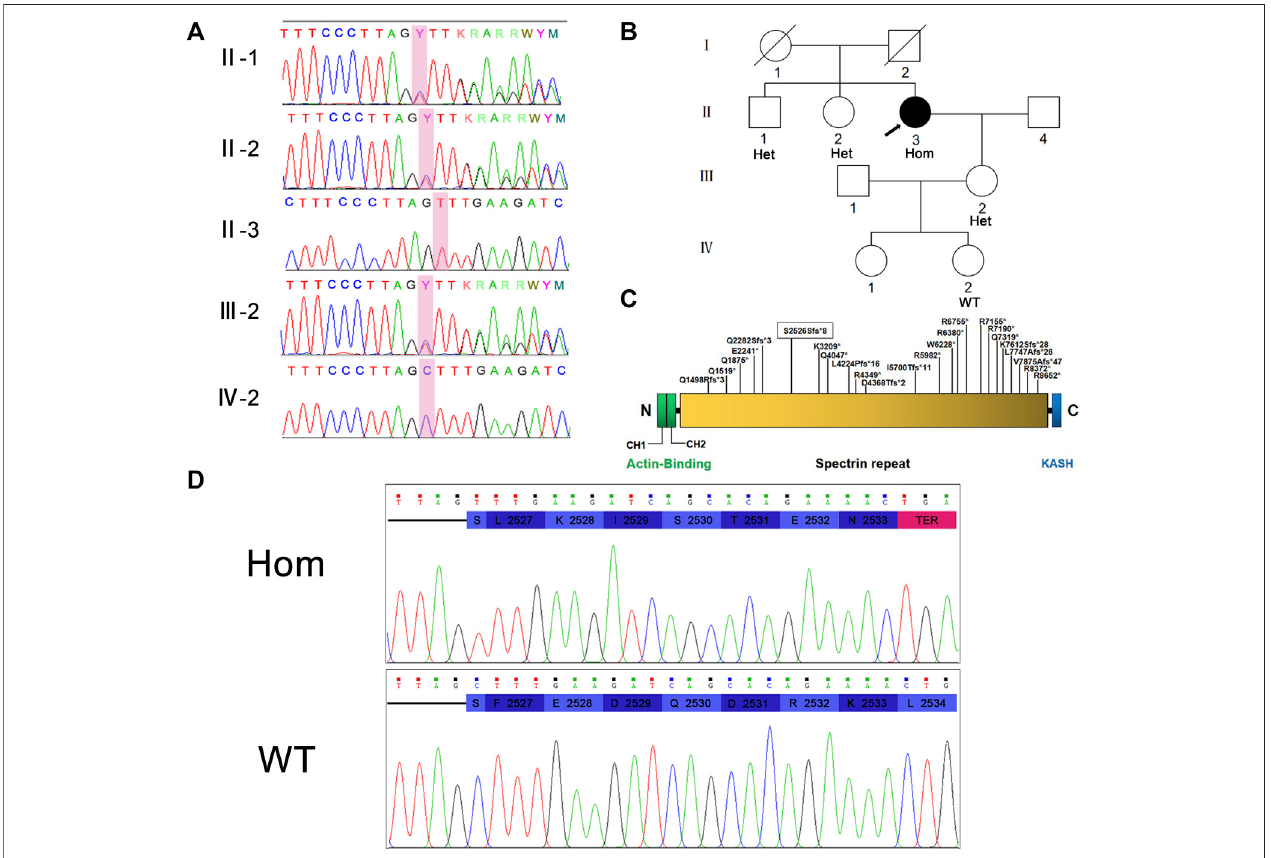
FIGURE 2 | (A) Sanger sequencing peaks of family members. (B) Pedigree of family. II-3 is the proband. (C) Nesprin-1 and the location of previously reported truncated variants are illustrated. The variations found in this study are marked with boxes. (D) Translation pattern diagram. The mutation c.7578del (p.S2526Sfs*8) occurredinexon51of SYNE1 gene,leavingtheserineatposition2,526unchanged.Thesubsequentcodonframeshiftmutationresultedinthesuspensionoftranslation of 7 amino acids and the deletion of protein fragments (including KASH